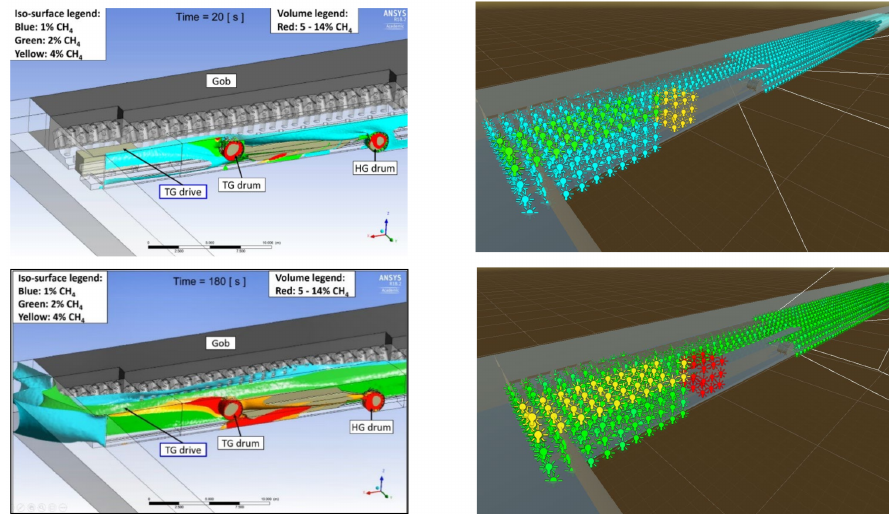
Figure 6. Side-by-side comparisons of CFD models and prediction visualizations